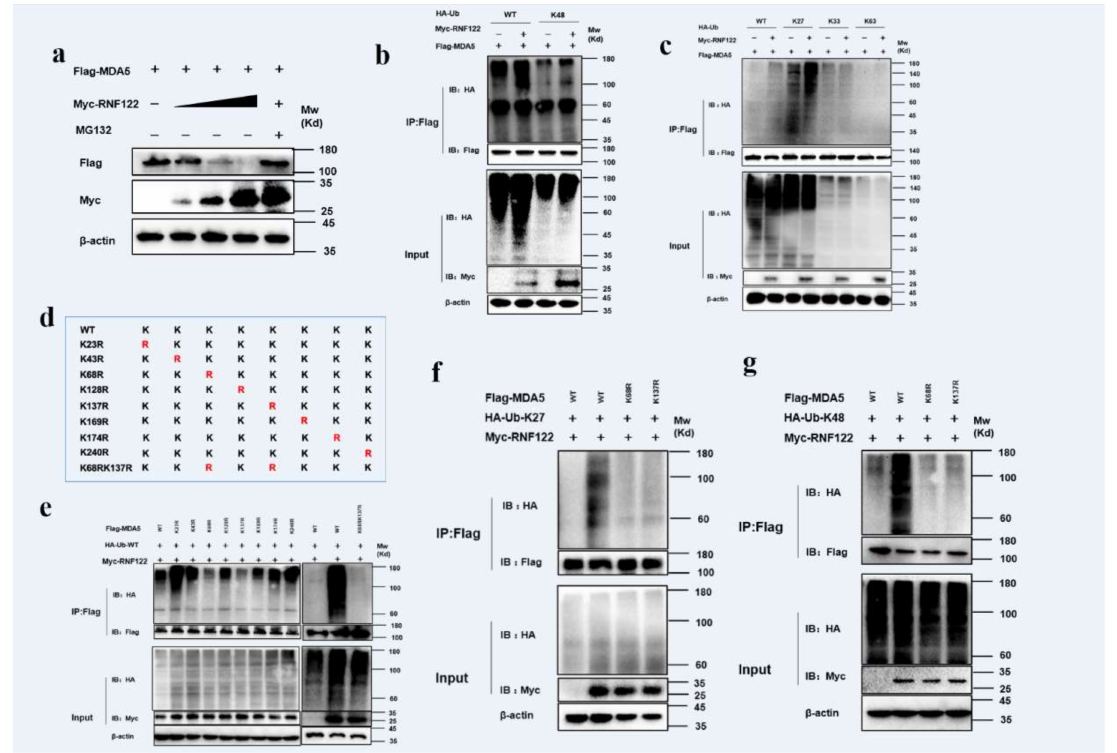
Figure 10. Porcine RNF122 performed K27-linked and K48-linked ubiquitination to MDA5. ( a ) HEK293T cells were co-transfected with Flag-MDA5 (1 µ g) and Myc-RNF122 (0 µ g, 0.5 µ g, 1 µ